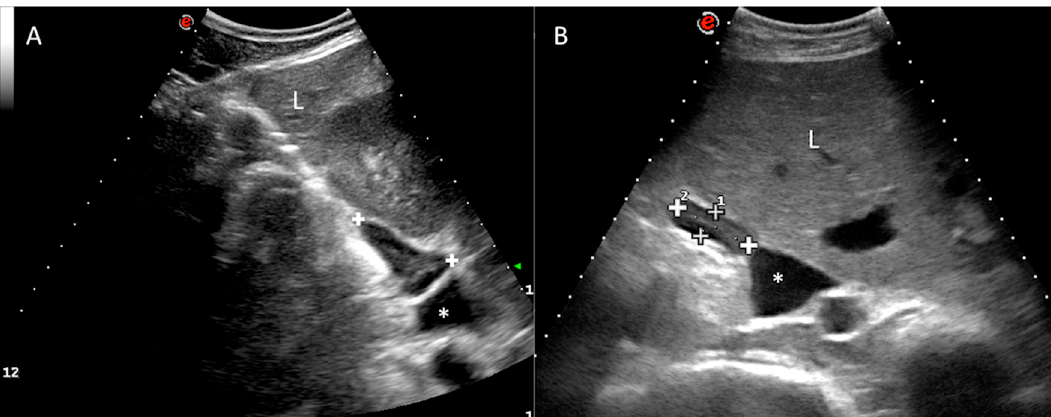
Figure 2. Right adrenal gland. Transverse plane of the abdomen obtained at the level of the 12th right intercostal space, showing the right adrenal gland (between cursors or “+” sign) with an “L” shape ( A ) or elongated shape ( B ). The medulla can be observed as an echoic internal band. Dorsal is to the left of the image. Caudal vena cava (*). Liver (L). Kidney (K).